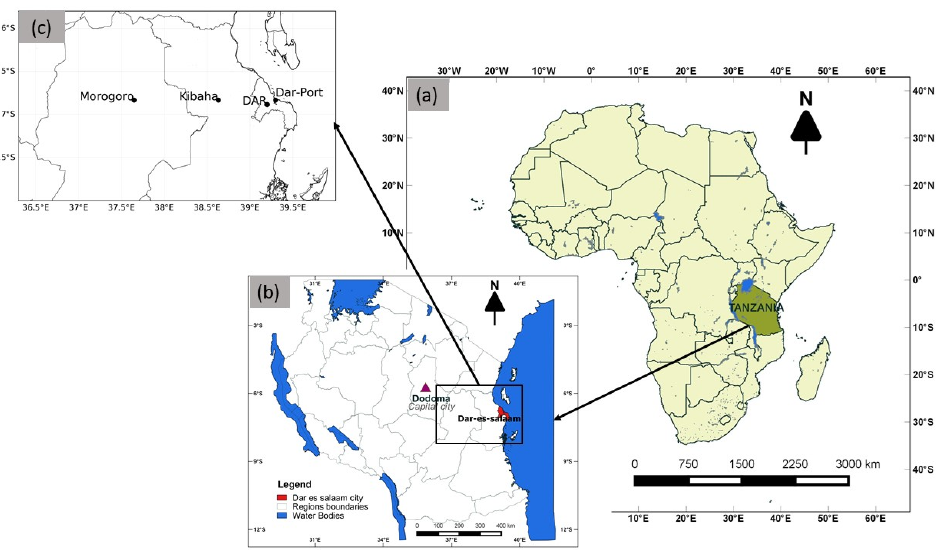
Figure 1. ( a ) Location of Tanzania in Africa continent, ( b ) Tanzania with study area, and ( c ) Study area with stations used in this study. Dar es Salaam is shaded in red in Tanzania map.